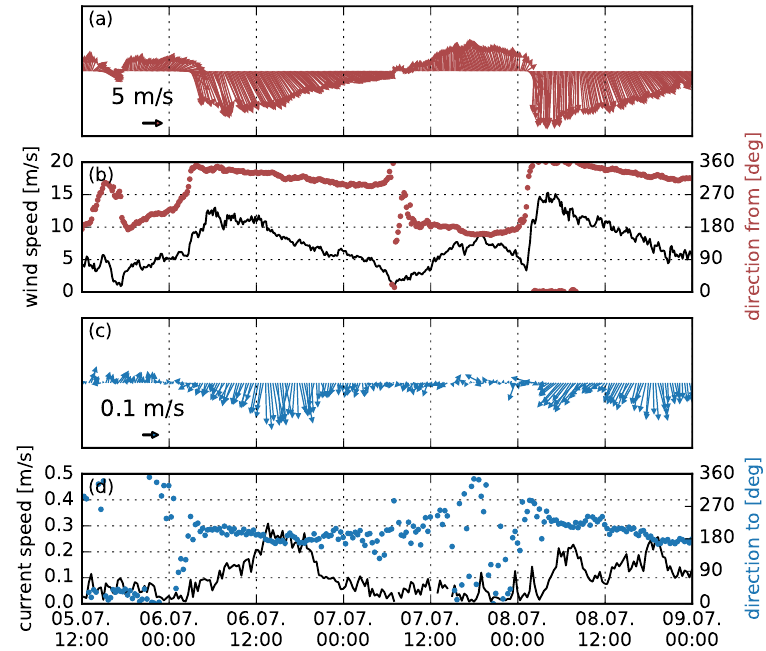
Figure 10. Wind speed and direction at Isokari AWS ( a , b ) with current speed and direction at Lövskär crossing ( c , d ) 5–9 July 2013. Locations of the measurement stations shown in Figure 1.